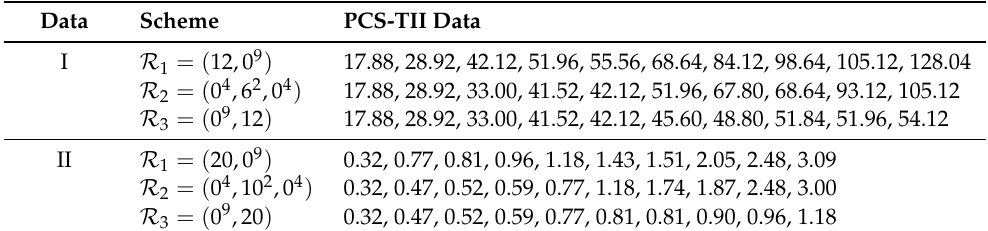
Table 5. Three different generated progressively censored data